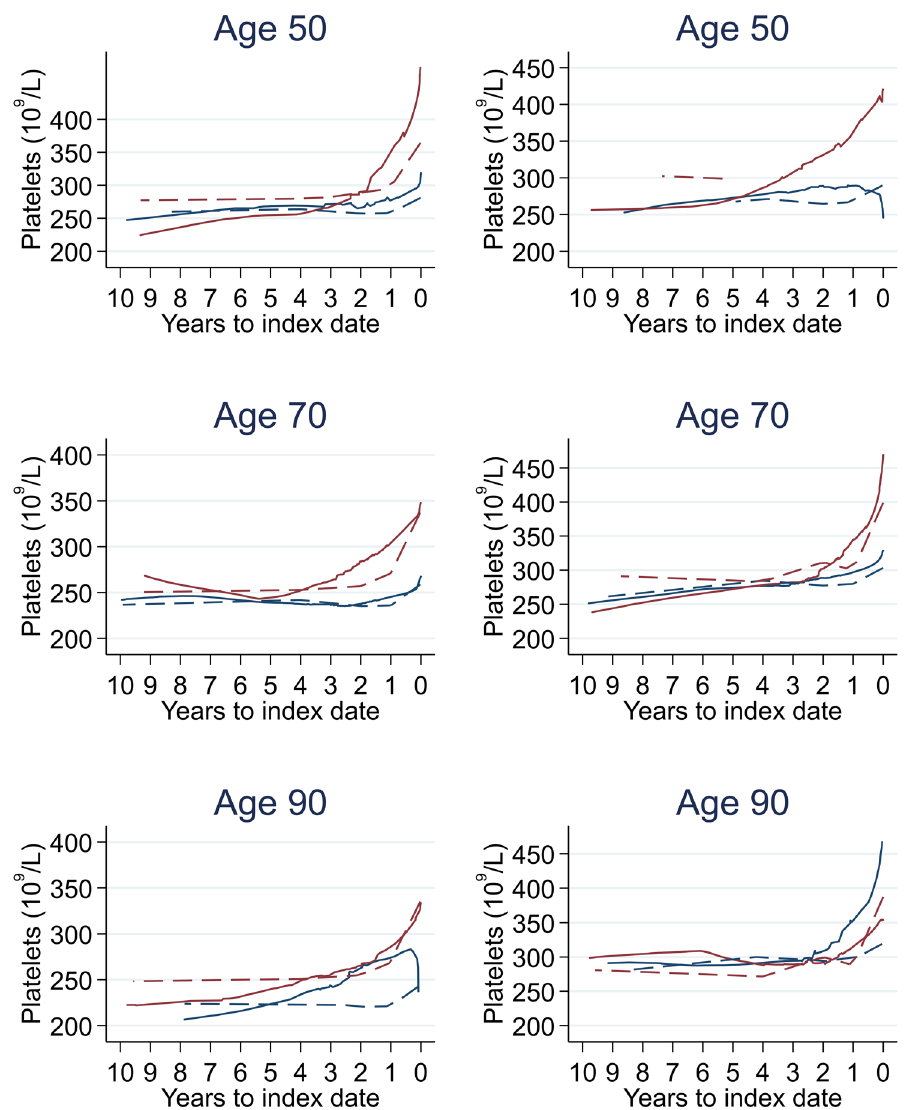
Figure 22. Platelet trends between Duke’s A and D tumour stage by age at index date 1,2 . 1 Index date was the date of diagnosis for cases and a randomly selected date in the patient’s study period for controls. 2 LOWESS trends are age (+/- 3 years) and modelled (fixed effects) trends are taken at that specific age. Legend: males (left) and females (right). Stage A (blue line) and Stage D (red line). LOWESS trend (solid line) and modelled trend (dashed line).